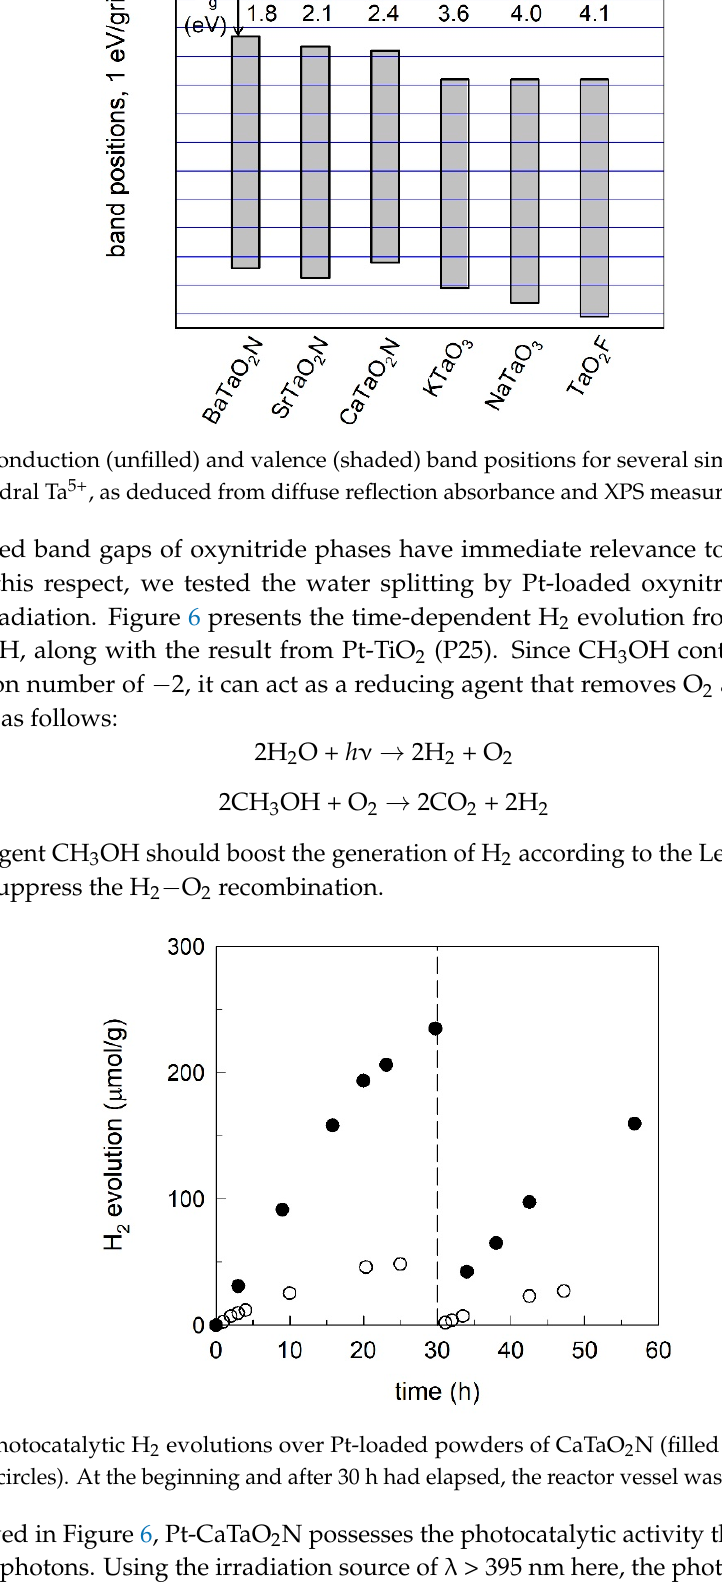
Figure 6. Photocatalytic H 2 evolutions over Pt-loaded powders of CaTaO 2 N (filled circles) and P25 TiO 2 (open circles). At the beginning and after 30 h had elapsed, the reactor vessel was purged with Ar.